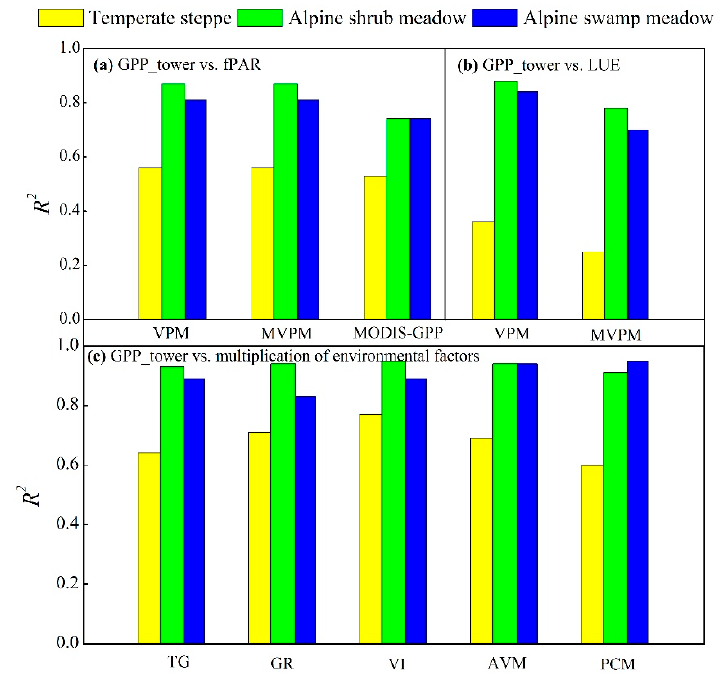
Figure 8. The R 2 of ( a ) GPP_tower vs. fPAR, ( b ) GPP_tower vs. LUE for the three LUE models and ( c ) GPP_tower vs. multiplication of environmental factors for the five statistical models in the temperate steppe, alpine shrub meadow, and alpine swamp meadow ( p < 0.01). The R 2 value between the GPP_tower and LUE for MODIS-GPP was not calculated due to the unavailability of the LUE data used by the model. The multiplication of environmental factors for the TG, GR, VI, AVM, and PCM are EVI × Scaled_LST, EVI × PAR, EVI × EVI × PAR, EVI × Ta, and EVI × LSWI, respectively.